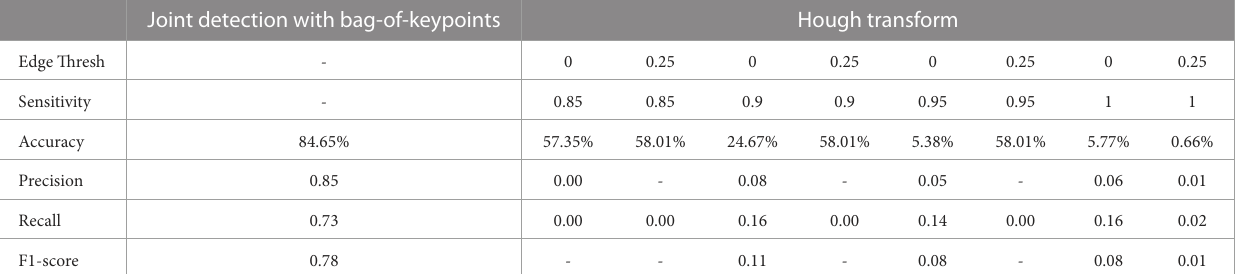
TABLE1 Comparisonofjointdetectionusingthebag-of-keypointsmethod versus theHoughtransform(wheretheedgethresholdandsensitivityoftheHough transformarevariedsystematically).NotethatincertaininstancestheHoughtransformfailstodetectanycirclesthereforePrecisionandF1-scoreareundefined, whichisindictedwitha“-”.